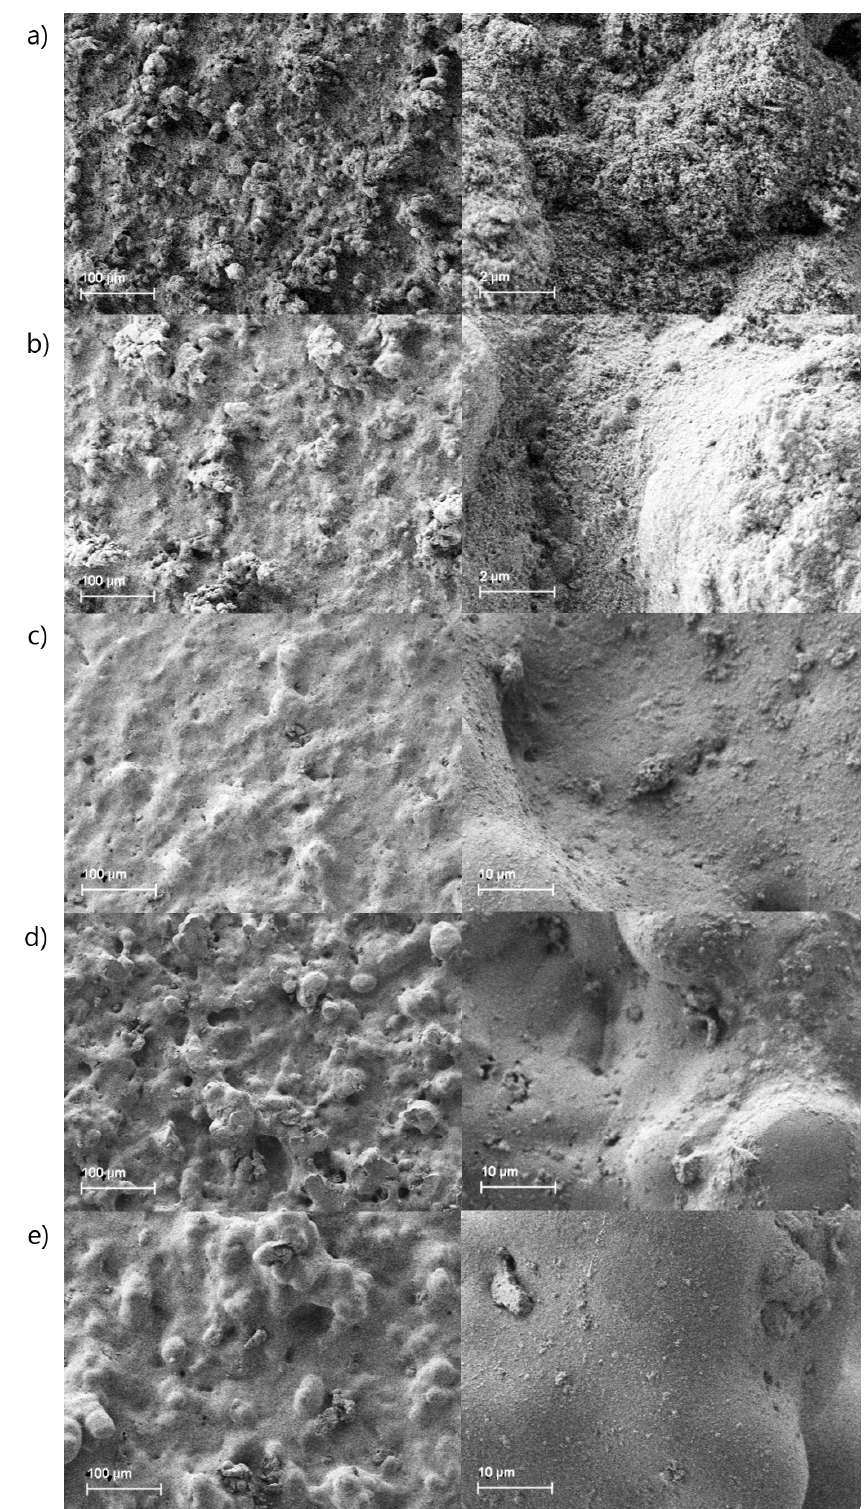
Figure 5. FE-SEM micrograph of coating surface with different magnification with respect to FAS amount ( a ) C1, ( b ) C2, ( c ) C3, ( d ) C4, and ( e ) C5. The morphology shows micro-bumps, which contribute to the roughness while C1 and C2 exhibit hierarchical structure.